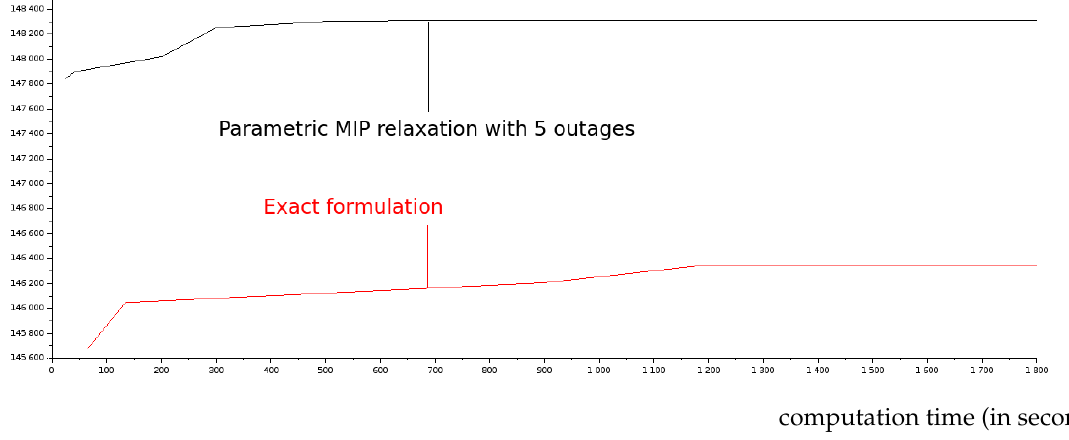
Figure 2. Comparison of dual bound convergence using MILP computation of LB and LB ( 5 ) formulations for instance B6 (relatively easy) and for difficult instance